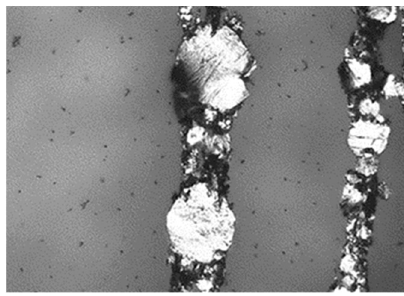
Figure 9. Normal grain atlas.